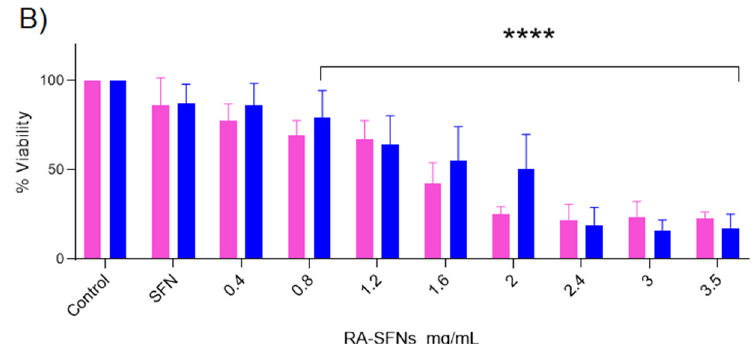
Figure 8. Cytotoxic effect of free RA ( A ), and RA-SFNs ( B ) on HeLa and MCF-7 cell lines. Data are expressed as percentage of cell viability ± SD vs. concentration. * indicates p < 0.05, ** indicates p < 0.01, *** indicates p < 0.001 and **** indicates p < 0.0001, compared to control. SFNs without drug were tested at the highest concentration of RA-SFNs (3.5 mg/mL). Table 3. IC 50 values for RA, RA-SFNs and RA contained in RA-SFNs (calculated from DLC value) against HeLa and MCF-7 cell lines as determined by MTT assay. Values were calculated by GraphPad Prism